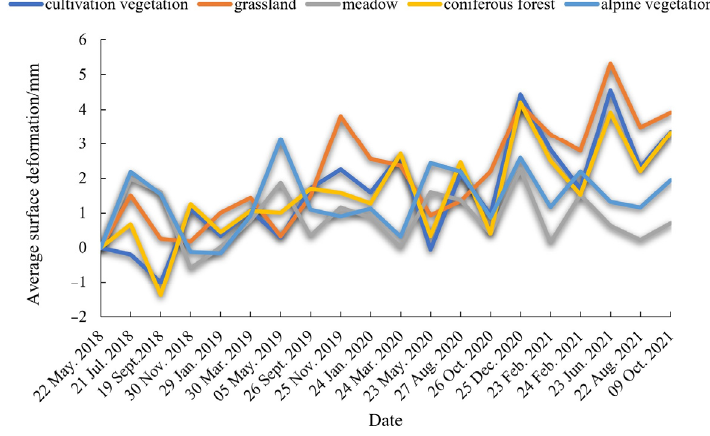
Figure 11. Surface deformation of different vegetation types during the monitoring period.